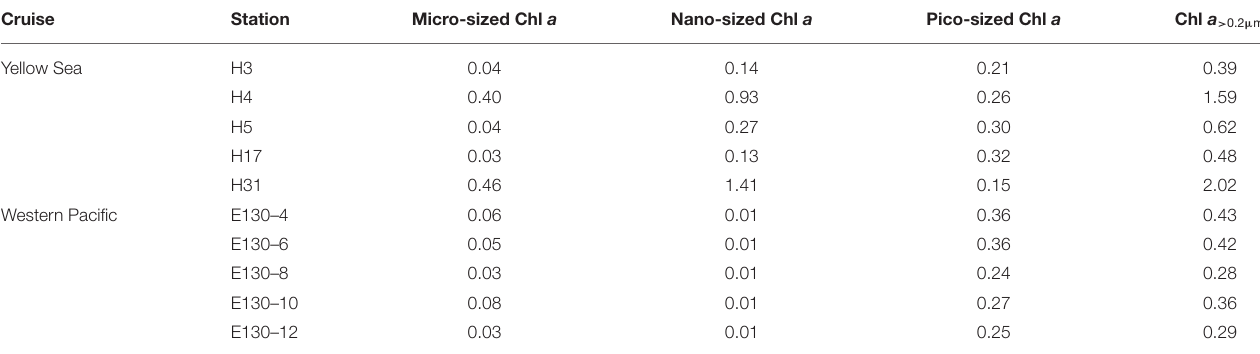
TABLE 2 | Depth-weighted averages of total and size-fractionated Chl a concentrations ( µ g L − 1 ) among sampling stations in the Yellow Sea and the Western Pacific.